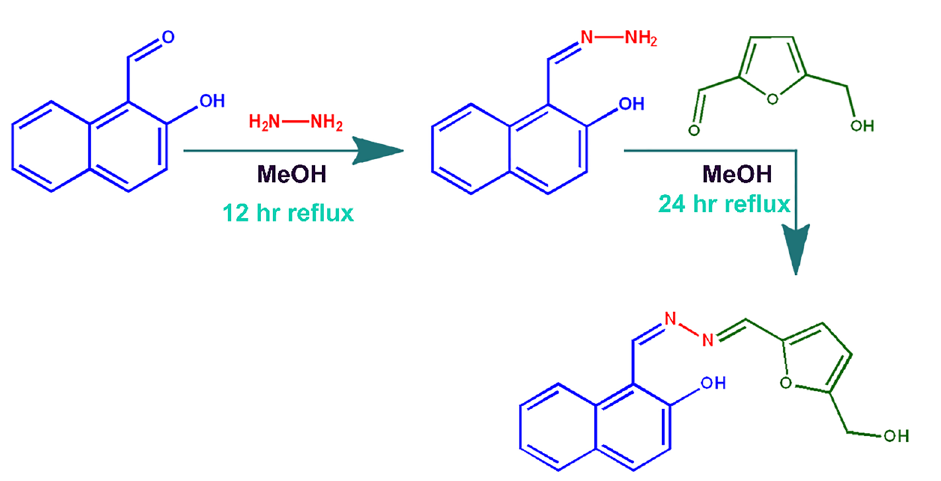
Figure 6. Synthesis of the probe NAF